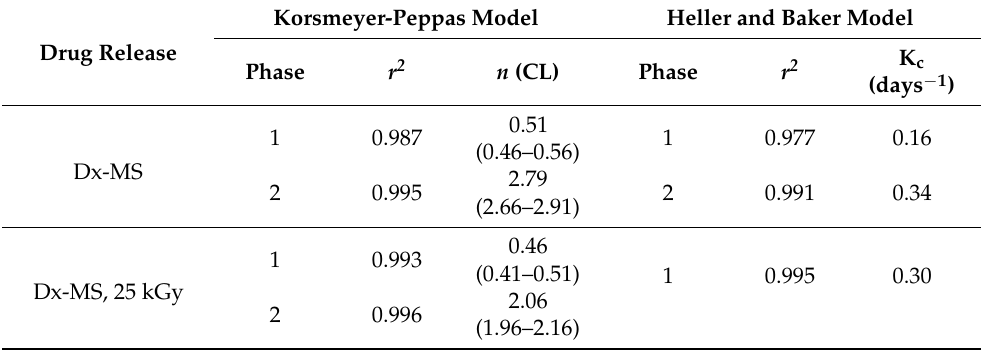
Table 4. Values of kinetic parameters of drug release profiles before and after sterilization. The value of “ n ” of Korsmeyer–Peppas model (95% confidence level, CL), “K c ” of Heller and Baker model, and coefficients of determination ( r 2